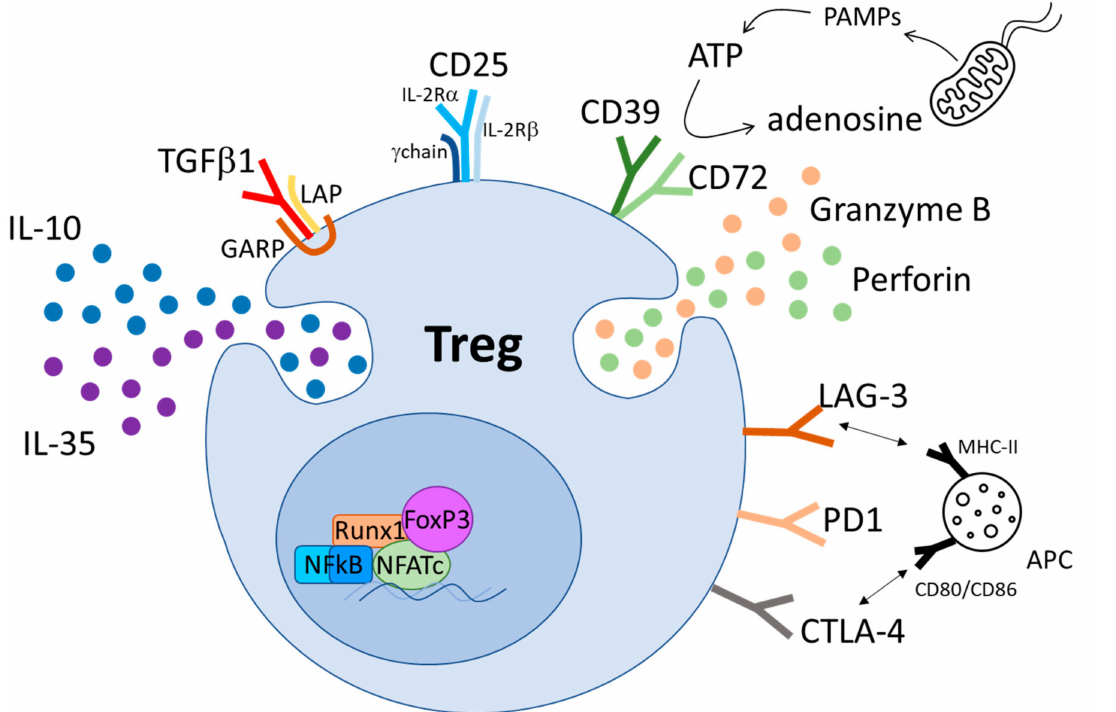
Figure 1. Treg-mediated mechanism of suppression. The FoxP3-containing transcription complex induces the expression of immunosuppressive cytokines (i.e., IL10, IL35 and TGF β ), cytotoxic molecules (i.e., Granzyme B and perforin) and surface molecules involved in Treg-mediated suppressive activity (i.e., CD25, CD39, CD72, LAG-3, PD1,